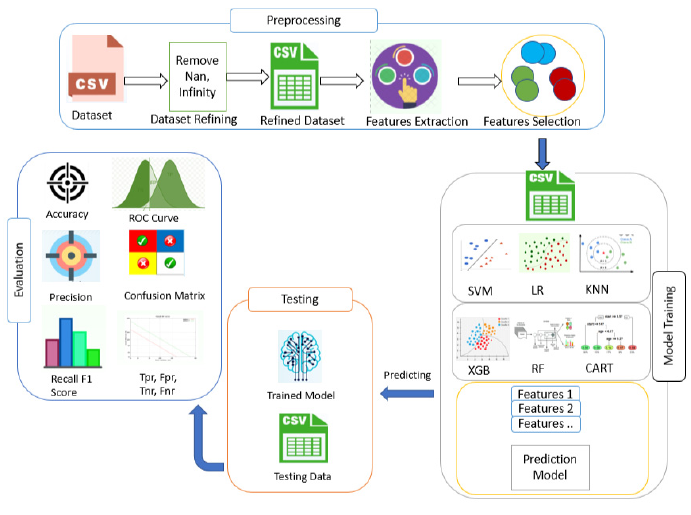
Figure 2. Proposed model.